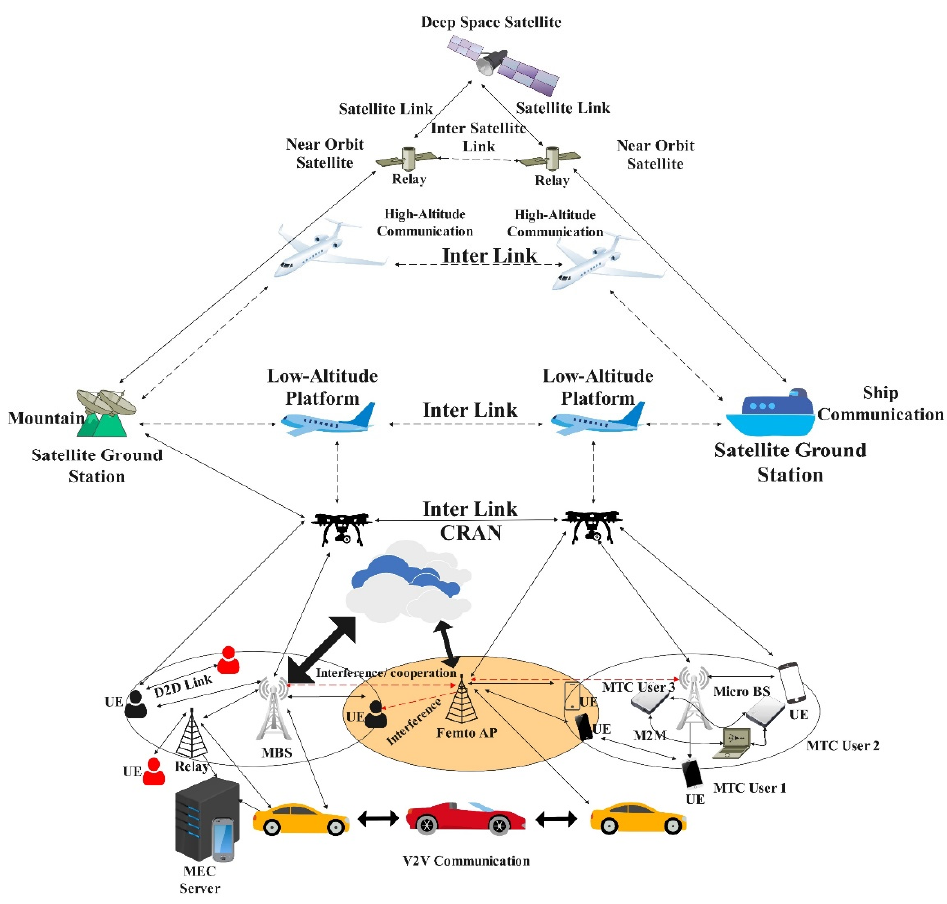
Figure 4. The structure of future HetNets.